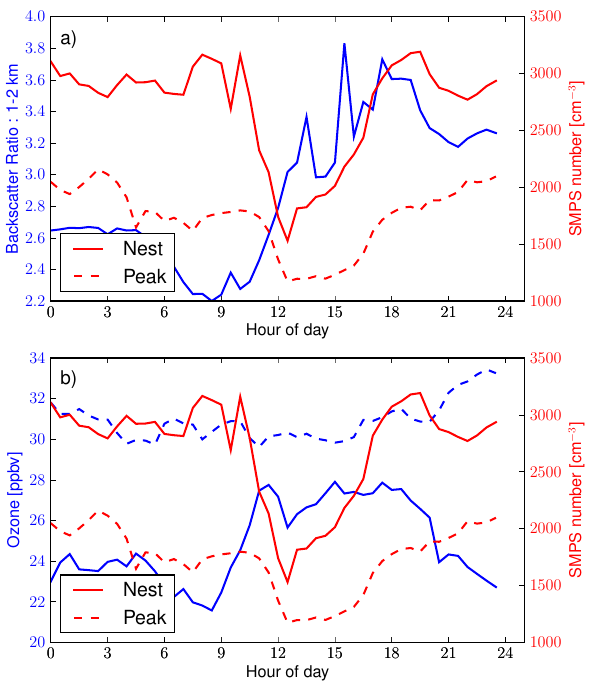
Fig. 4. (a) Lidar backscatter ratio profile vs. height and time. Dashed black lines show the altitudes of Raven’s Nest and Whistler Peak (however, mixing along the side of the mountain may be dif- ferent than in the clear air above the Lidar, so these heights might not actually represent the backscatter ratio at the two measurement sites). Solid black line and right axes shows estimated downwelling shortwave radiation at the surface. (b) Ozone timeseries at Raven’s Nest and peak and wind direction at Raven’s Nest.